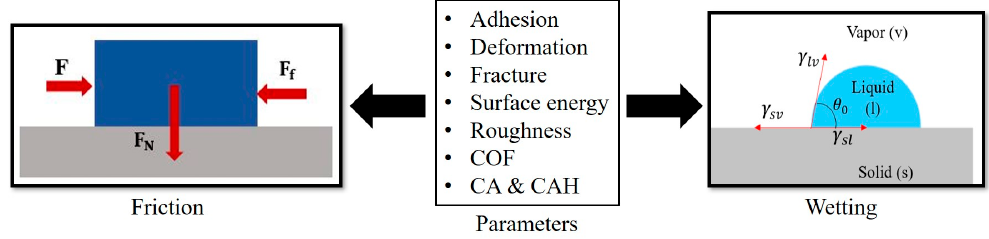
Figure 1. Parameters interrelating friction and wetting.